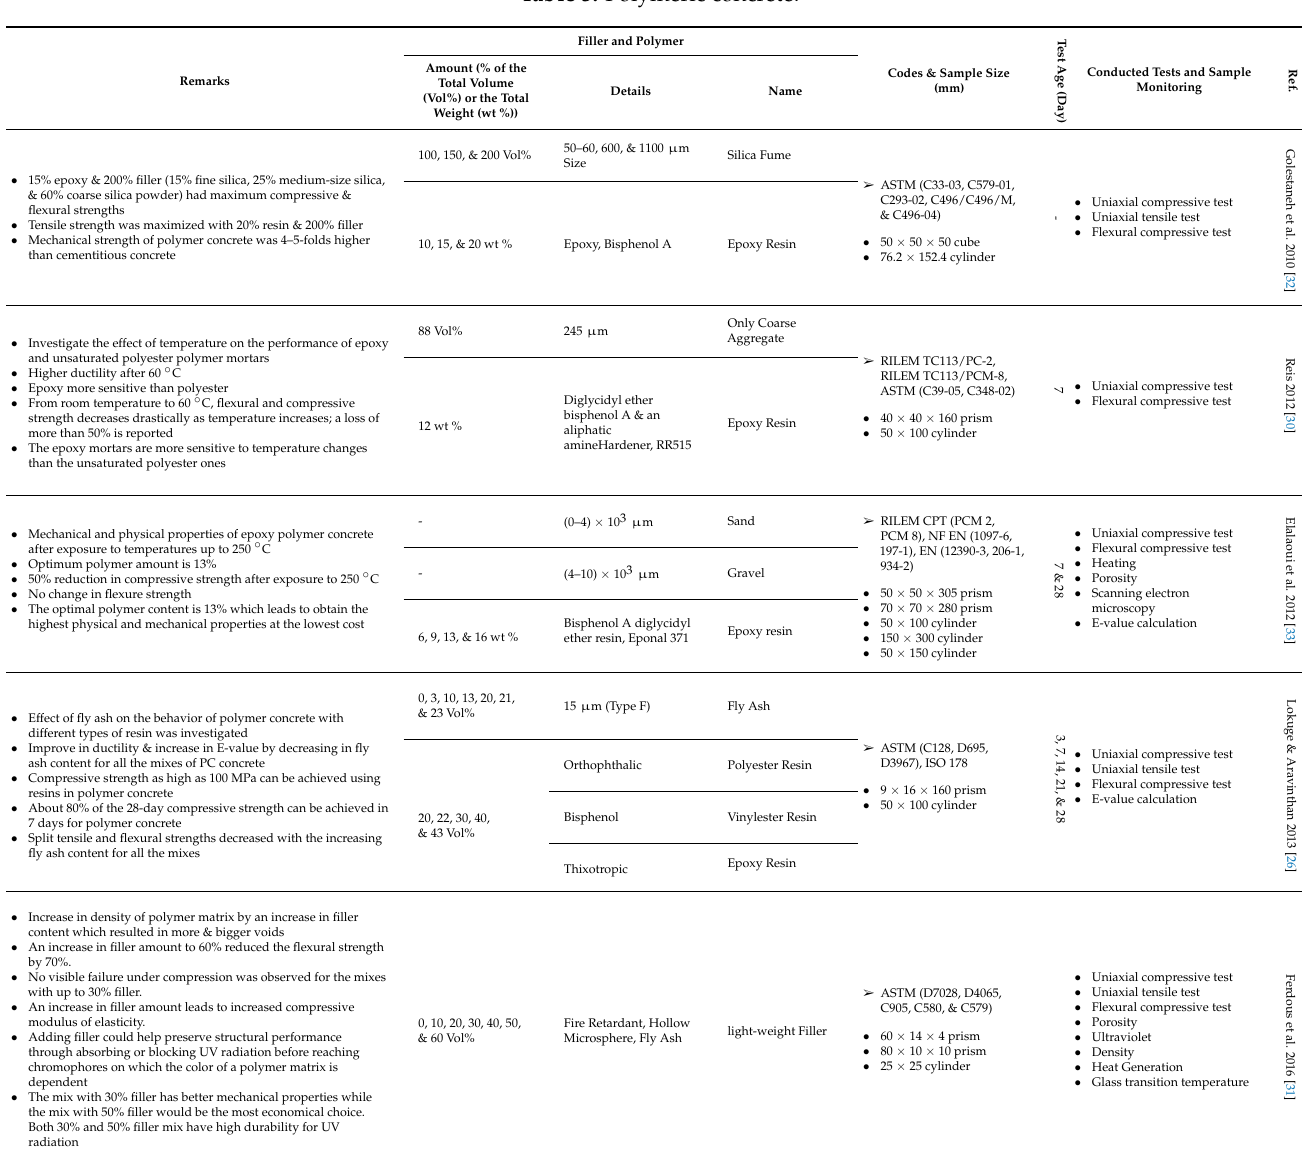
Table 3. Polymeric